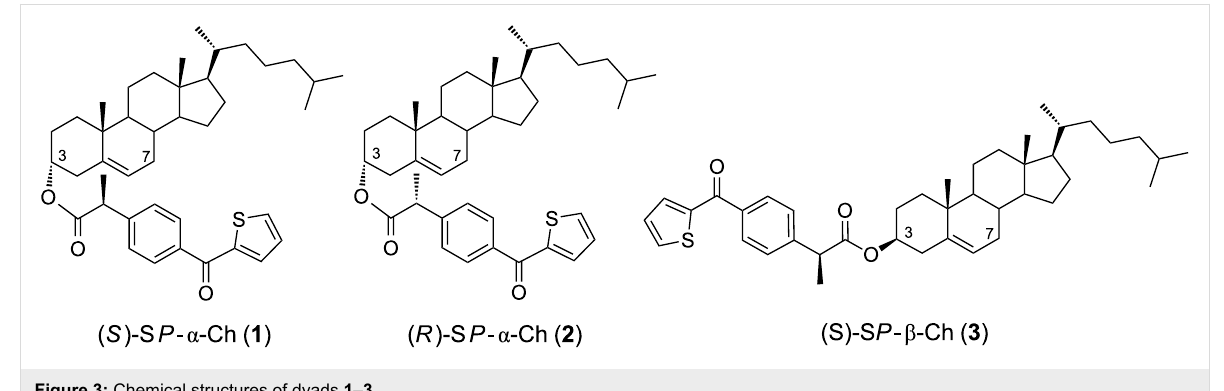
Figure 3: Chemical structures of dyads 1 – 3 .